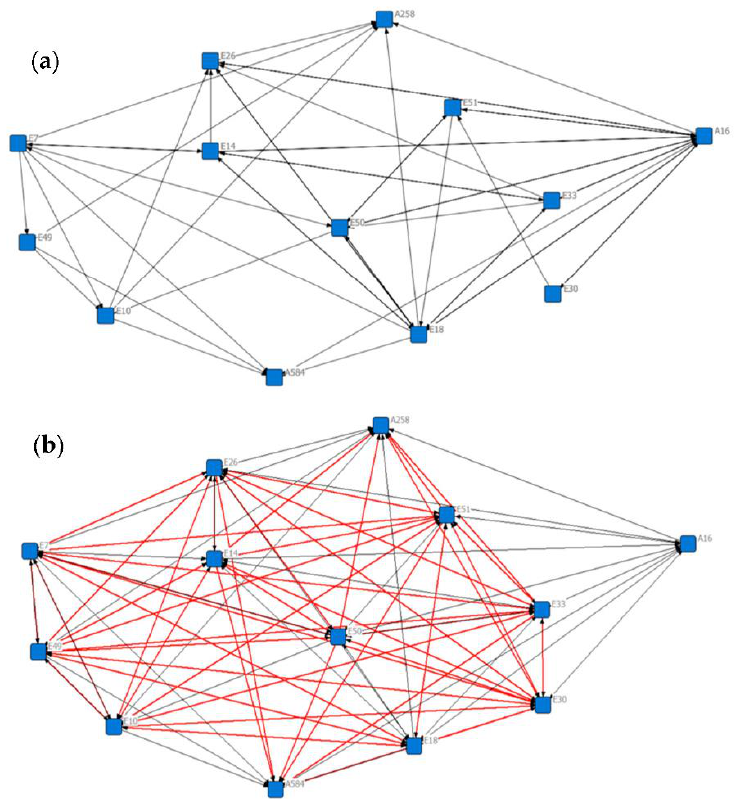
Figure 3. Social network of the main stakeholders involved in Ecofeixes. ( a ) Social network before the SI process. ( b ) Social network during the SI process. Symbols in blue represent individuals. Lines in black represent previous relationships. Lines in red illustrate new relationships. Own elaboration based on the Social Network Analysis of quantitative primary data (2nd phase). Table 3. Key actors examined in the Social Network Analysis. Own